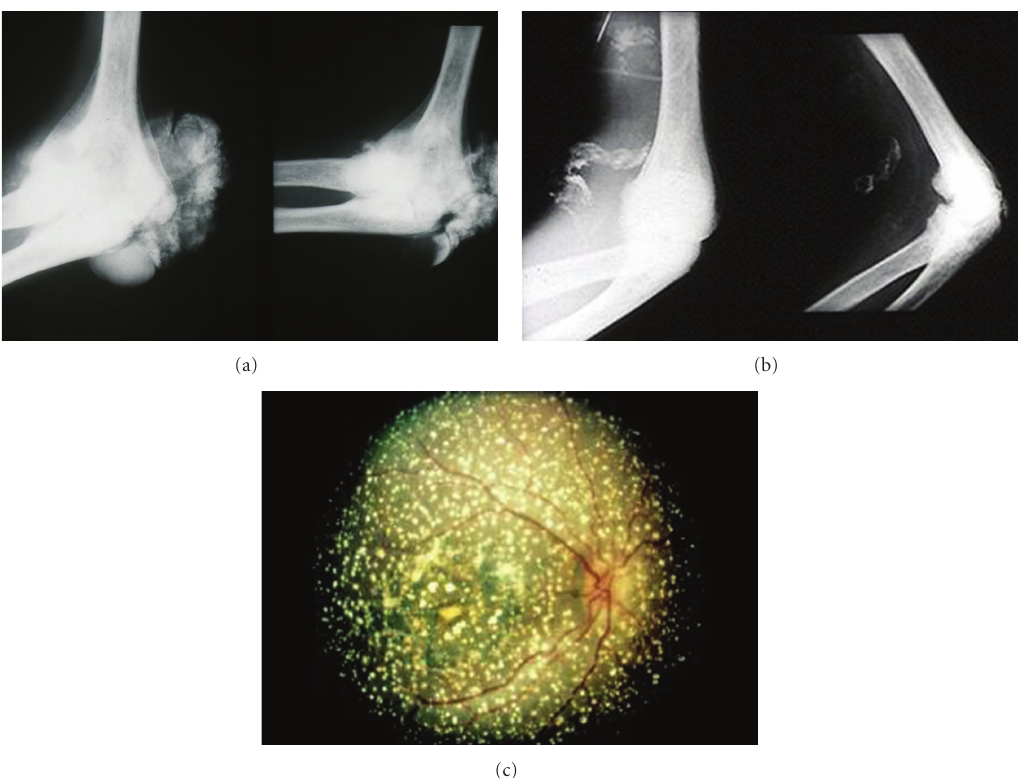
Figure 3: Systemic involvement (“oxalosis”) in PH1. Calcium oxalate deposition in the bones and joints (a), the vessels (b), and the retina (c).